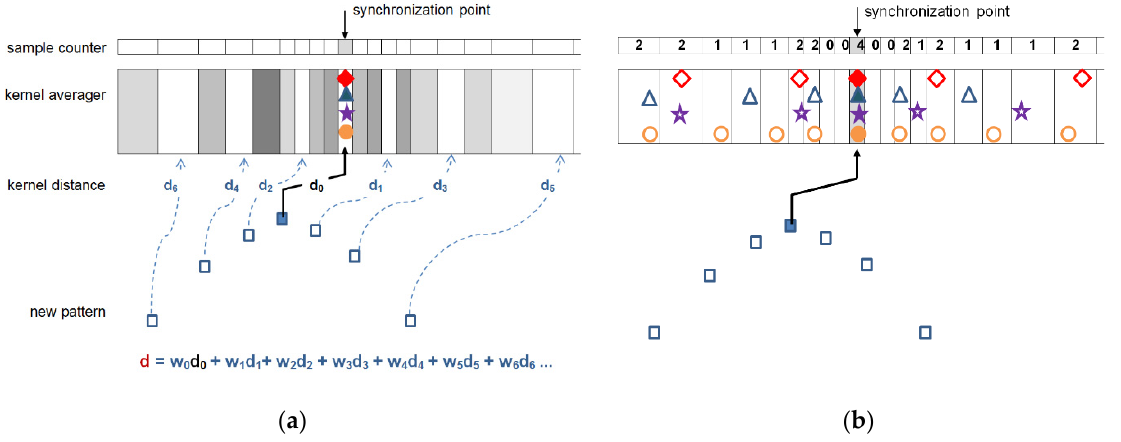
Figure 4. ( a ) Comparison of the non-uniformly sampled beat with the content of arbitrary class kernel; ( b ) arbitrary kernel pattern update by a newly accepted beat.